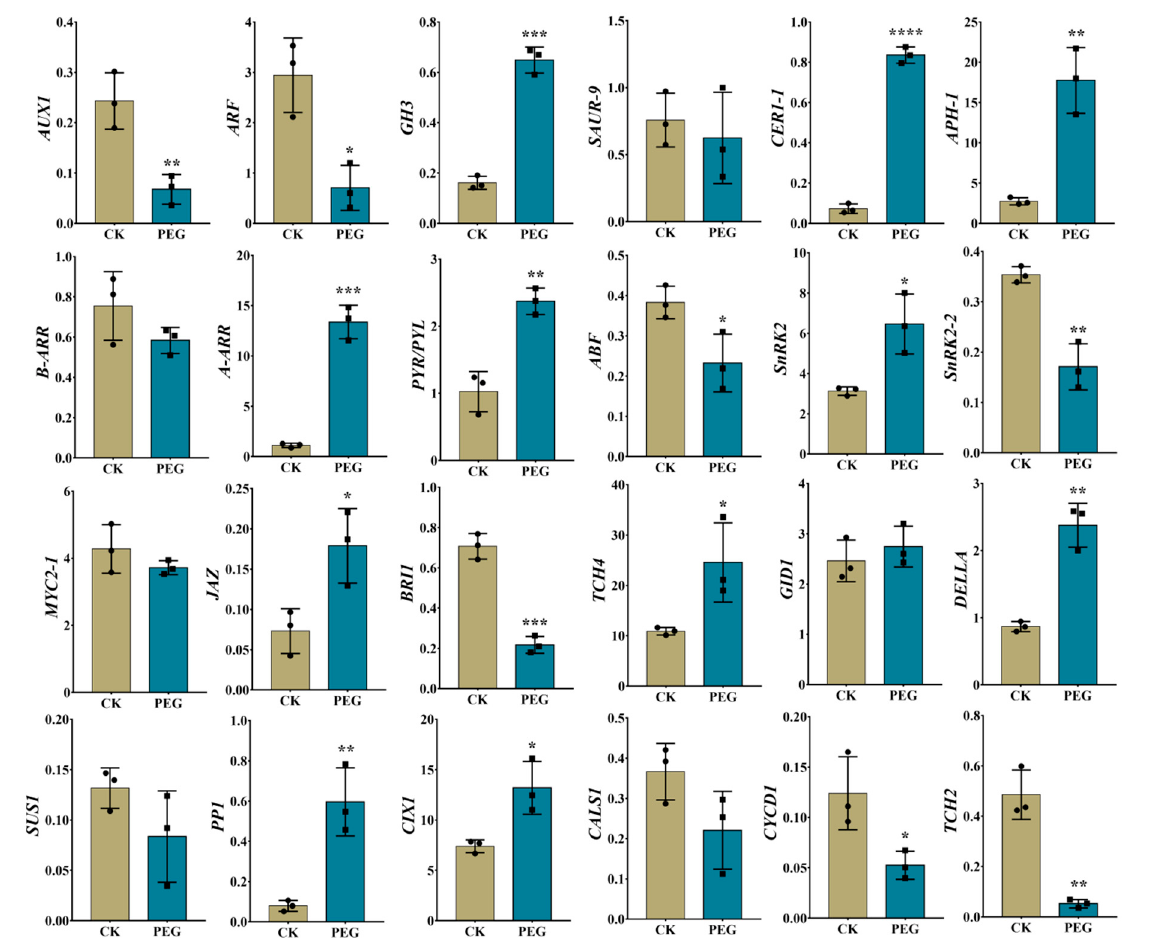
Figure 8. RT-qPCR-based results of randomly selected differentially expressed genes (DEGs) to validate the authenticity of the RNA sequencing data of polyethylene glycol (PEG) treated and PEG-free control (CK) treated cuttings at S2. Error bars refer to the average value ± SD from three biological replicates. Different asterisks indicate significant differences at ns p > 0.05, * p < 0.05, ** p < 0.01, *** p < 0.001, and **** p < 0.0001.